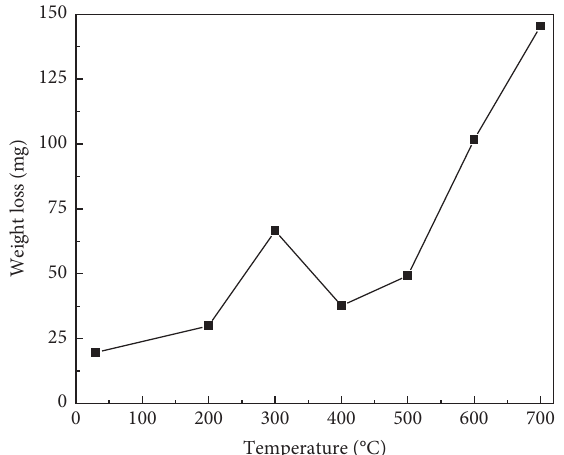
Figure 14: Effect of temperature on the wear weight losses of lower specimen.